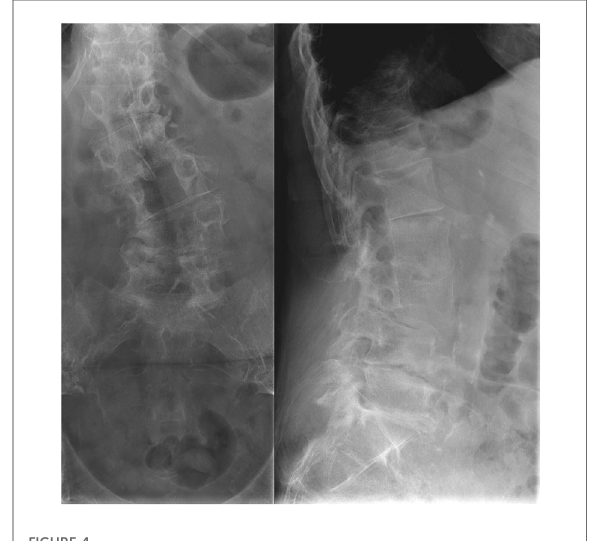
FIGURE 4 At the last follow-up, 4 years after the second surgery, the patient was still complaining of low back pain but was manageable with conservative methods, despite radiological progression of deformity: anteroposterior view (left) and lateral view